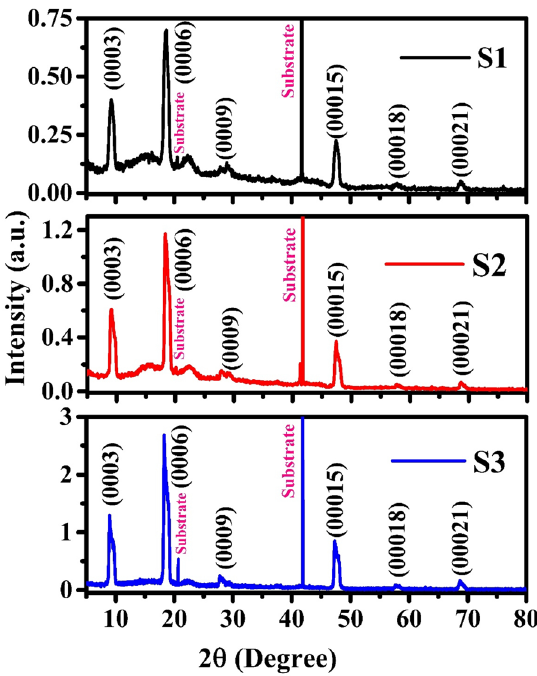
Figure 1. HR-XRD 2θ- ɷ scans of Bi 2 Se 3 thin films on sapphire (0001) of samples S1 (40 nm), S2 (80 nm) and S3(160